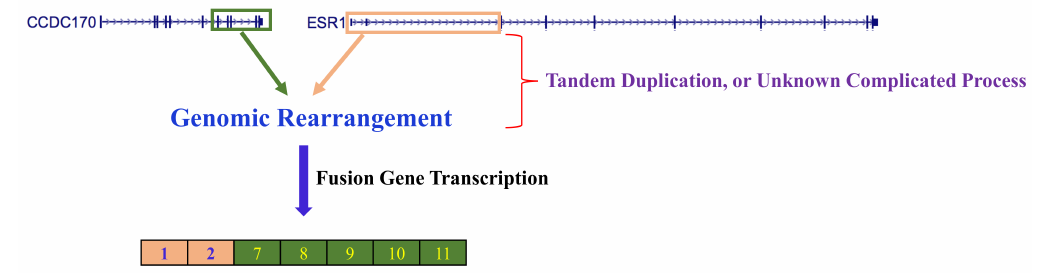
Figure 3. ESR1-CCDC170 fusion gene transcript formation. The intron 2 region within the ESR1 genomic locus appeared to undergo a DNA breakage, subsequently conjoining with the intron 6 region within the genomic locus of its neighboring gene CCDC170 . This genomic rearrangement results in an oncogenic fusion mRNA transcript involving an upstream part (exons 1 and 2) of ESR1 and the C-terminal portion (exons 7–11) of its neighboring gene CCDC170